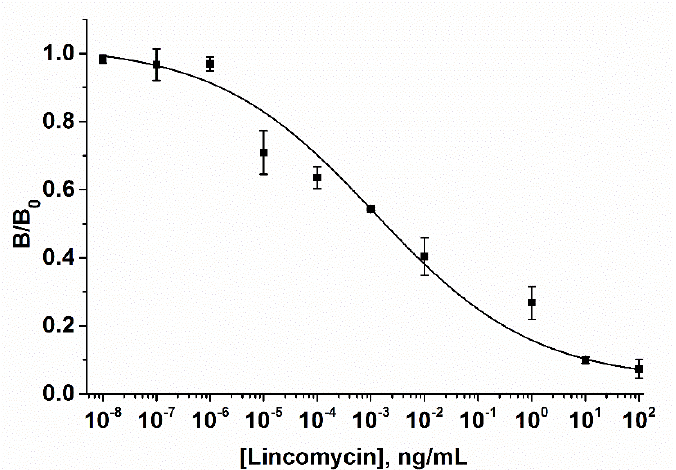
Figure 8. The calibration curve of the SERS-based LFIA for LIN detection according to the following optimal assay conditions: The amount of AuNPs–MBA–Ab bioprobe was 2 μ L; the LIN–BSA conjugate concentration was 0.2 mg/mL. The error bars indicate the standard deviation of the Raman intensities from MBA reporter molecule at 1077 cm − 1 measured from 10 points along the middle of the test line. Table 1. Lateral flow immunoassay (LFIA) tests for lincomycin detection. Target Analyte